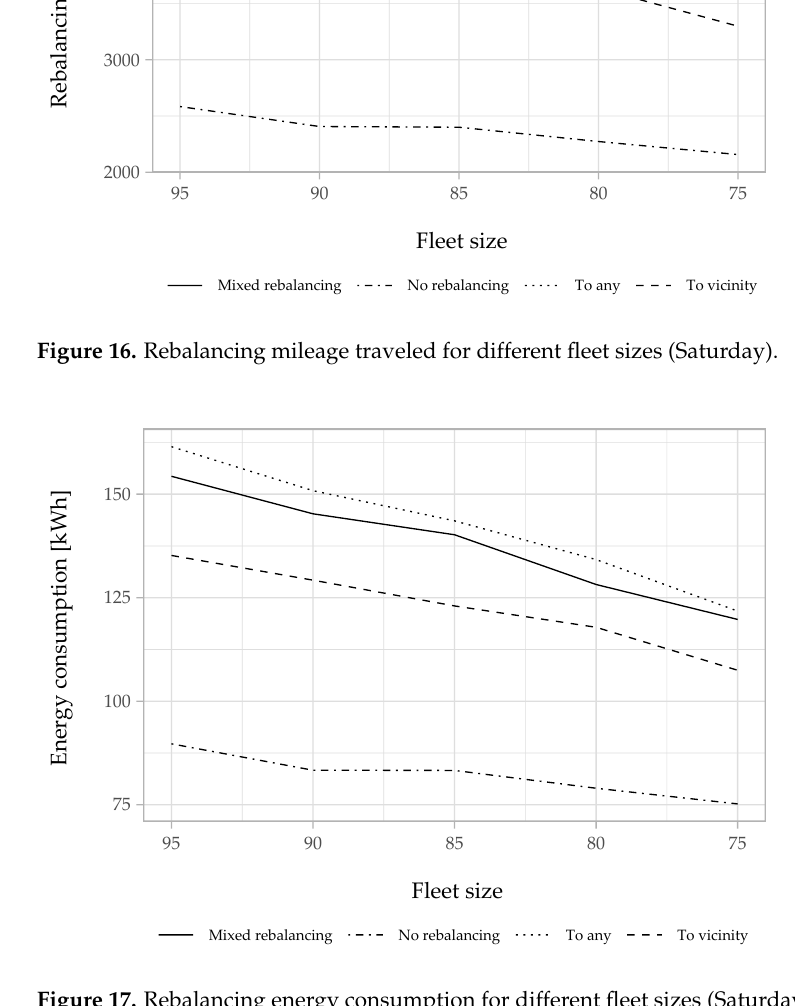
Figure 17. Rebalancing energy consumption for different fleet sizes (Saturday). The mileage traveled per bike and the energy consumed per bike are nearly constant, even when decreasing the fleet size for the different strategies, as shown in Tables 3 and 4. In this scenario, the mileage traveled per bike increases by at least 14 km, on average, when applying a rebalancing strategy. We also found approximately the same difference in the energy consumption as the workday scenario (about 500 Wh between the “no rebalancing” case and the “to vicinity”